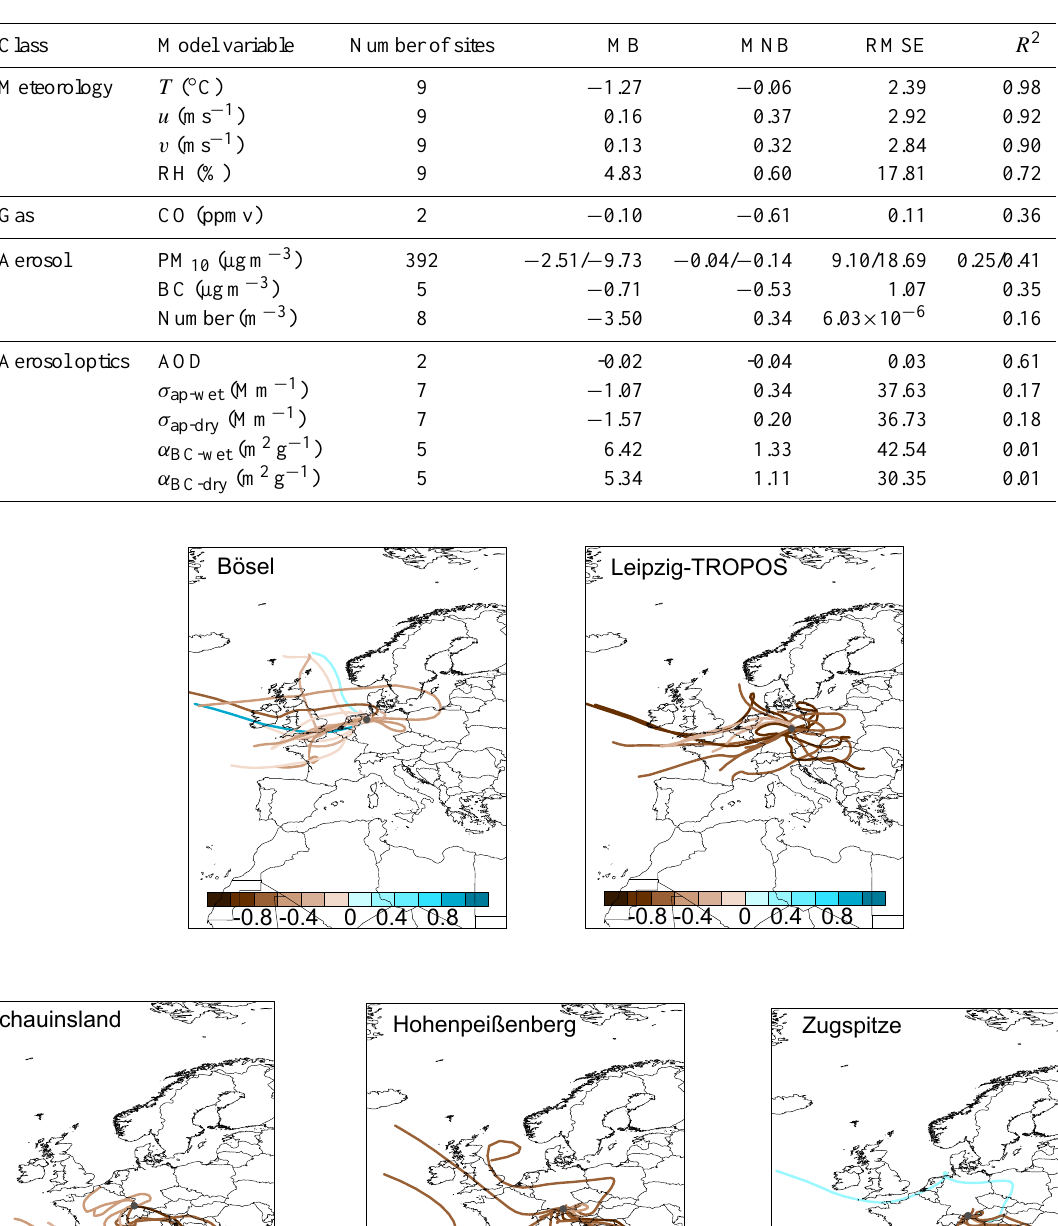
Table 3. Summary of values of mean bias (MB), mean normalized bias (MNB), root mean square error (RMSE) and coefficient of deter- mination ( R 2 ) derived from a comparison of different measurements and corresponding model values simulated in R1. The PM 10 statistics refer to the maritime/continental split of the simulation period. The AOD statistics refer to the sunphotometer observation technique. The results of the model meteorology comparison are shown for the surface layer as an average over the simulation period.